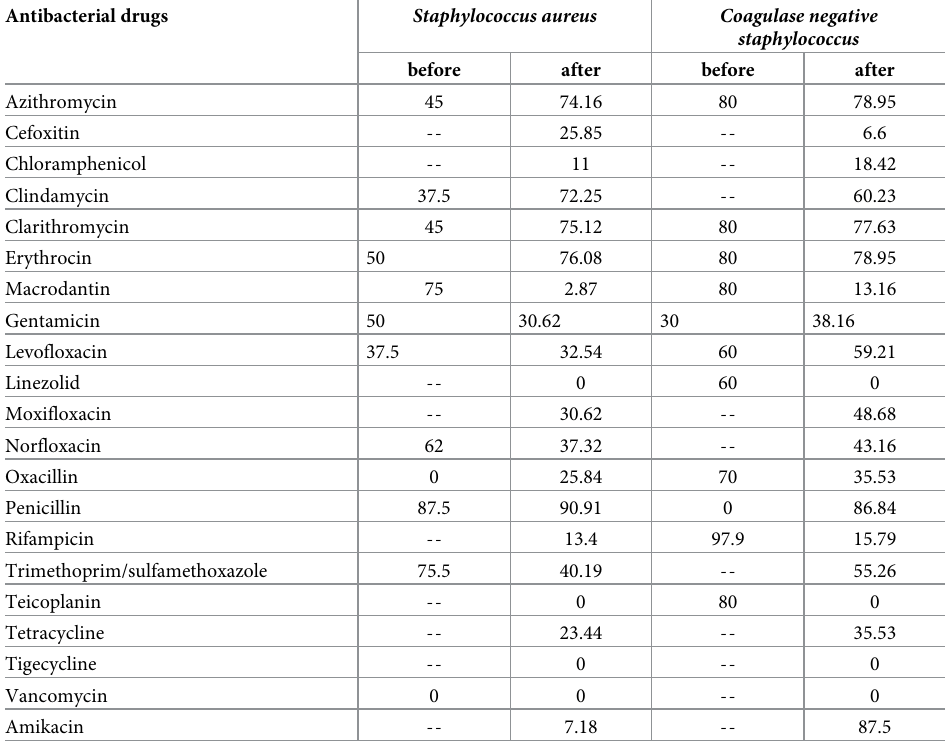
Table 4. The comparison of changes in the resistance rate (%) of the main G+ cocci to commonly used antibacte- rial drugs approximately 13 years ago. Antibacterial